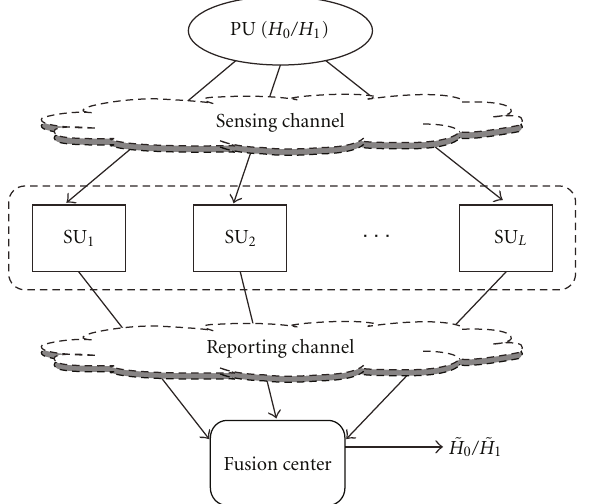
Figure 6: Multilayer distributed/cooperative spectrum sensing.